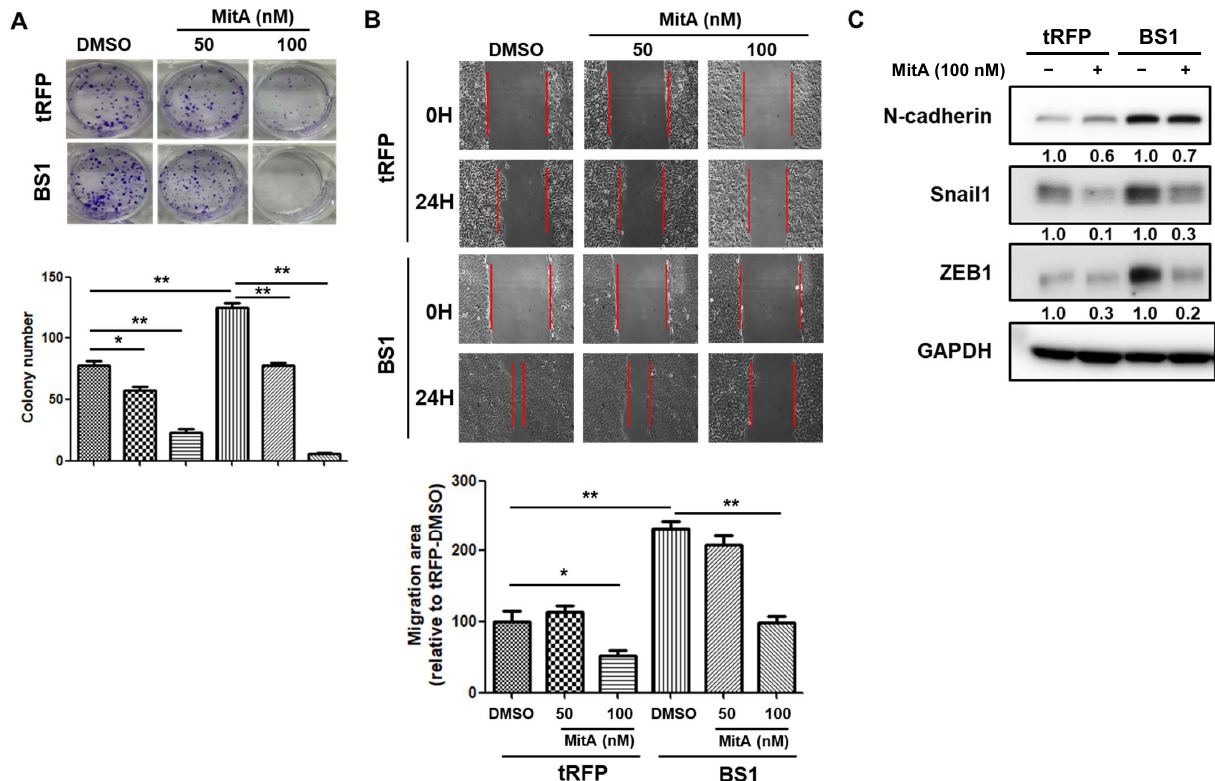
Figure 5. The inhibition of Sp1 activity reduces BMI1-induced malignant phenotypes in A549 cells. A549 or the derived BMI1 overexpressed A549-BS1 cells were treated with mithramycin A (MitA) at the concentrations of 50 or 100 nM. ( A ) Cell proliferation capability was measured by the clonogenic assay for 14 days. Cell colonies were visualized by the crystal violet stain. The statistical analysis